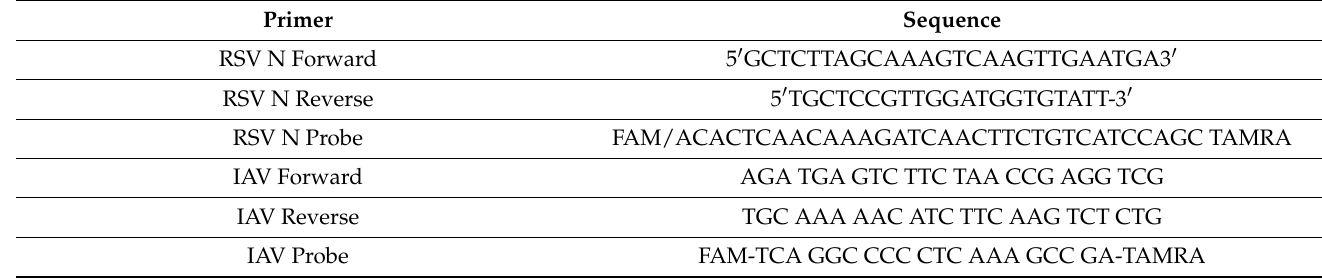
Table 1. IAV and RSV primers that were used in the